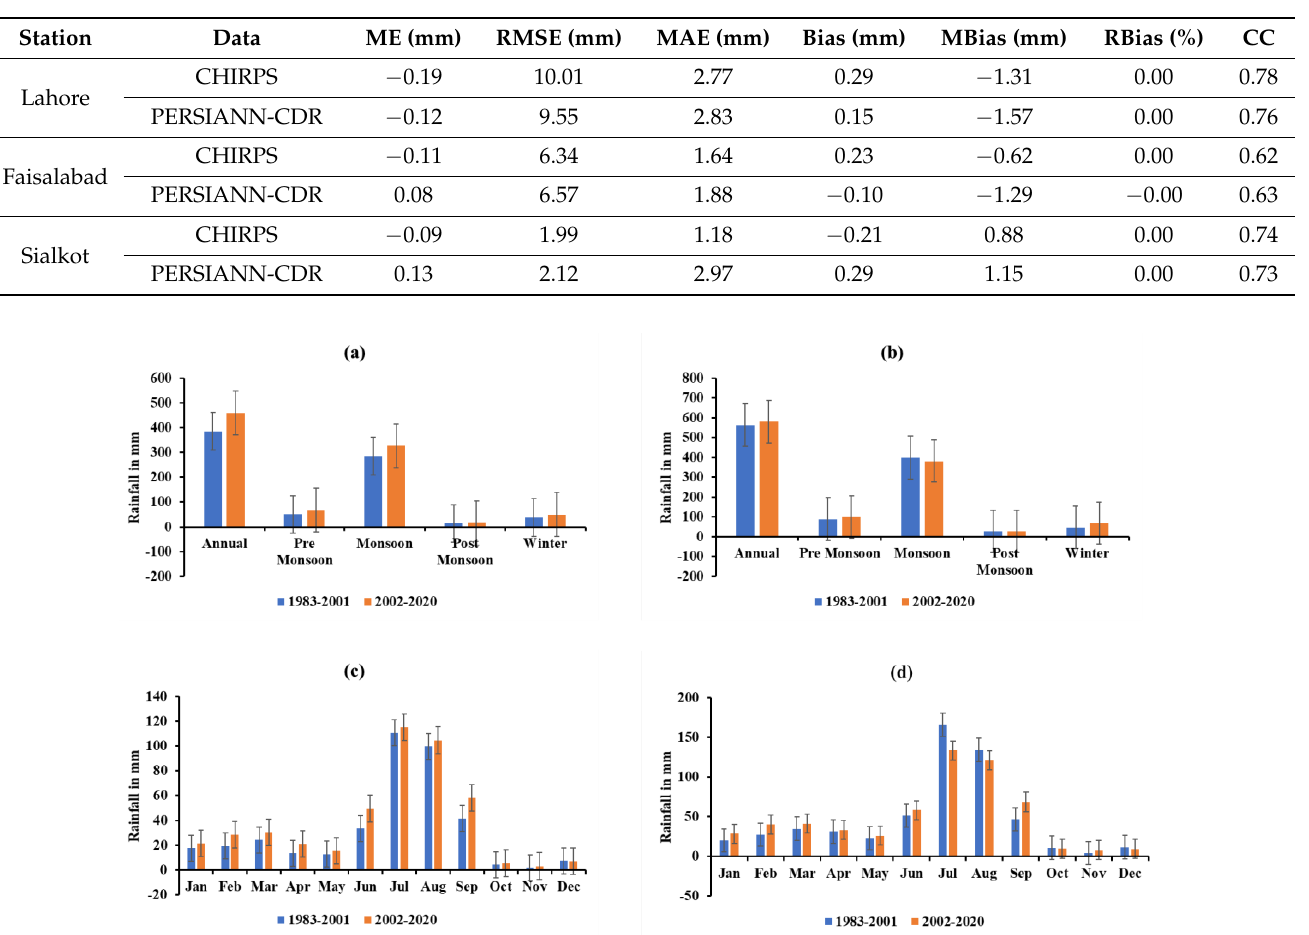
Table 2. Statistical indices to examine the similarity amid satellite data (CHIRPS and PERSIANN- CDR) and observed datasets.